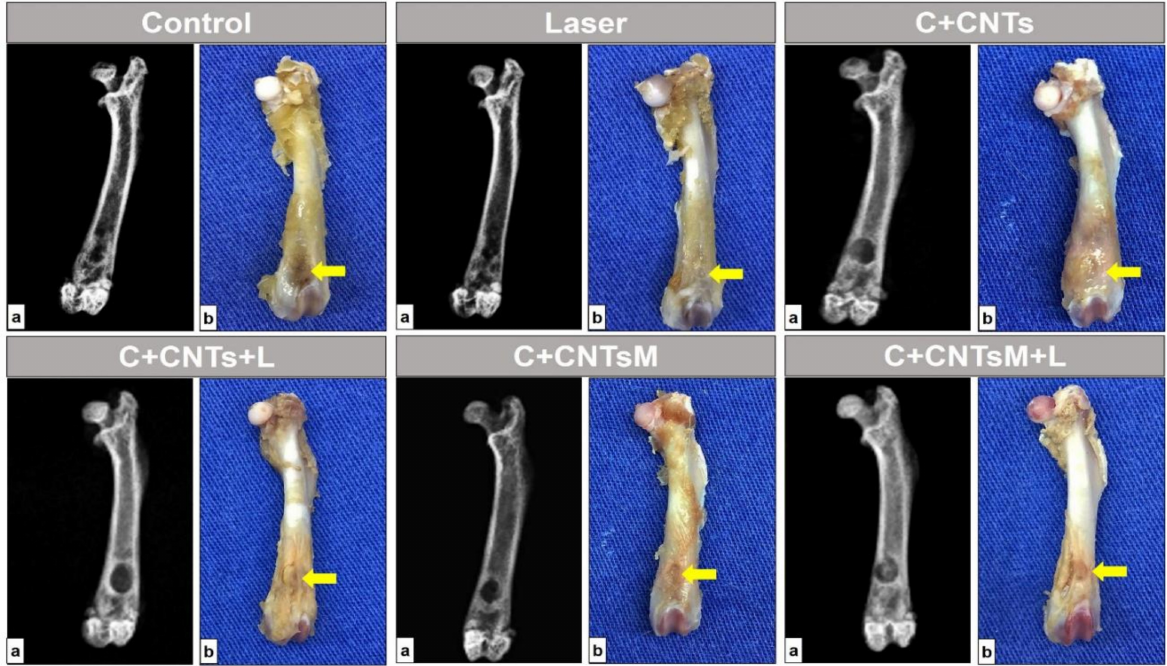
Figure 5. Radiological ( a ) and macroscopic ( b ) images of the left femur of rats in the study groups. Bone defects are indicated by the yellow arrows. Bone integrity is observed without injuries or secondary complications, as well as the presence of a bone defect that has not completely